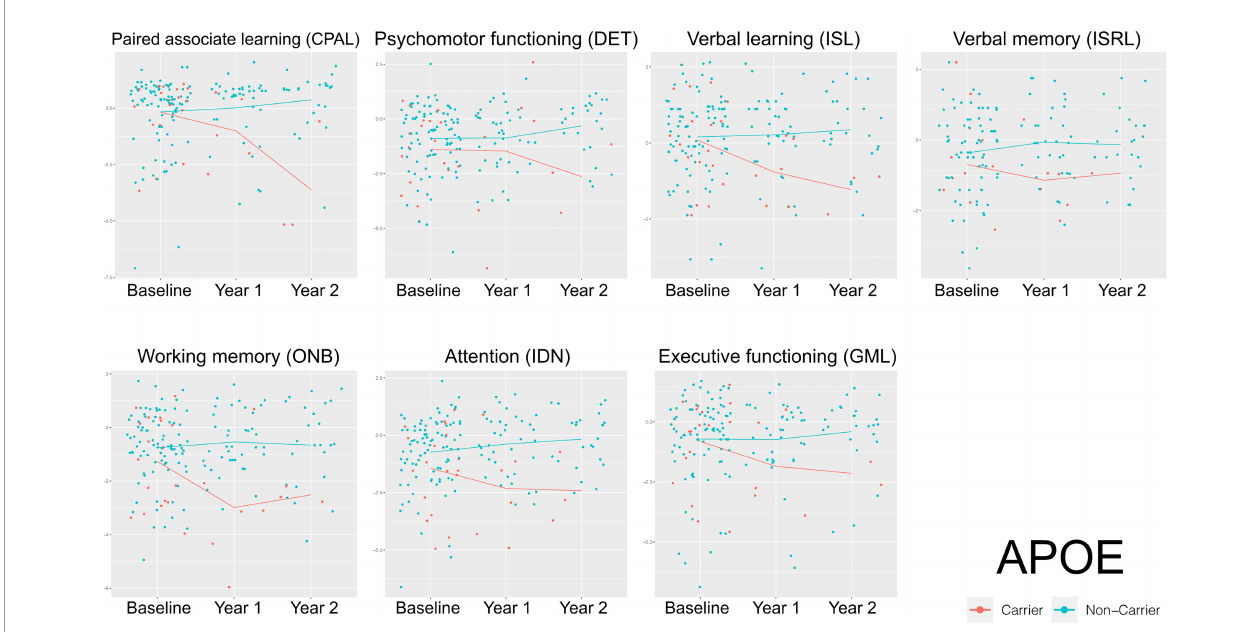
FIGURE 4 | Longitudinal impact of APOE ϵ 4 carrier status across each neurocognitive domain tested at baseline, Year 1, and Year 2 of enrollment. Trajectory of APOE ϵ 4 carrier versus non-carrier mean performance across each neurocognitive domain from initial neurocognitive testing (baseline) to timepoint 3 of neurocognitive testing (Year 2). Blue line=non-carrier, red